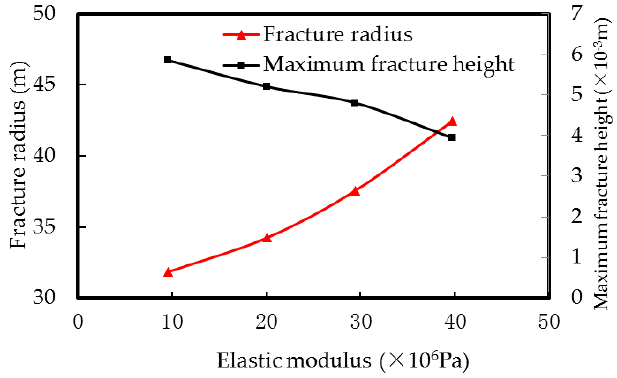
Figure 10. Influence of elastic modulus on fracture morphology.